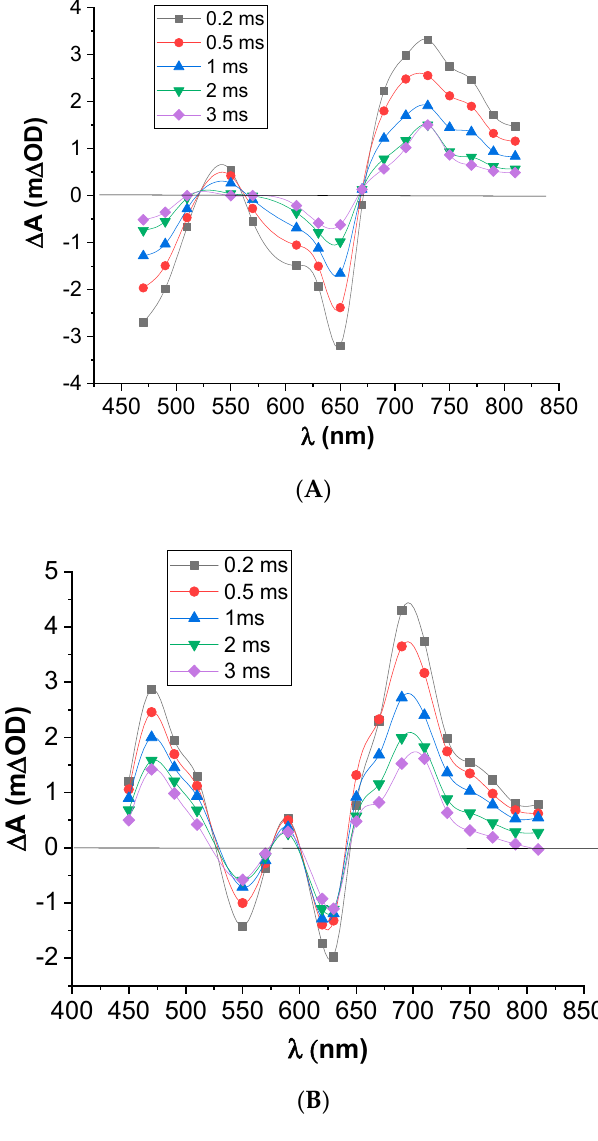
Figure 11. Transient absorption spectra of SnO 2 - 1 ( A ) and SnO 2 - 2 ( B ) at different delays from the 532 nm ns-laser excitation recorded at OCP in 0.1 M HClO 4 ; 1 M Ω oscilloscope resistance.